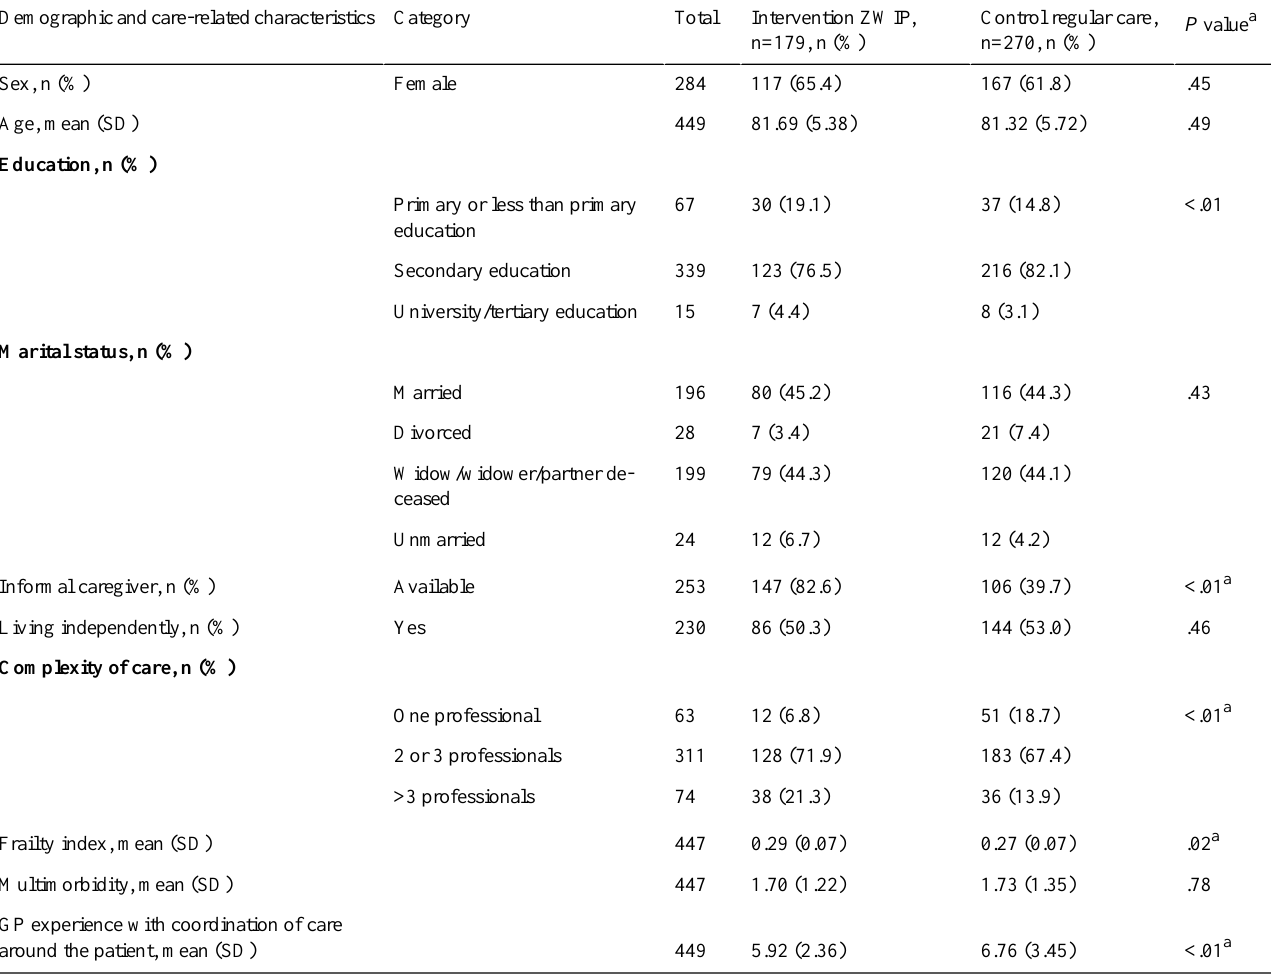
patient outcomes (Table 2). Change in coordination of care as reported by GPs improved in the control group. Table 1. Demographic and care-related characteristics in the intervention and control